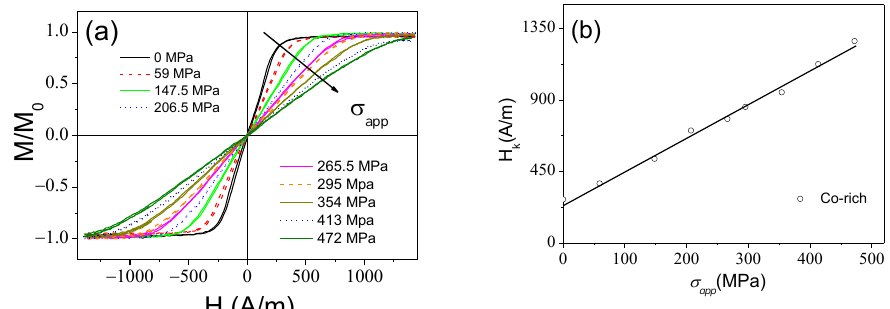
Figure 5. Effect of applied stress on hysteresis loops ( a ) and H k ( σ app ) ( b ) for as-prepared Fe 3.8 Co 65.4 Ni 1 B 13.8 Si 13 Mo 1.35 C 1.65 microwires. (Reproduced with permission from [71] Figures 2 and 3a Copyright © 2019 Elsevier B.V).